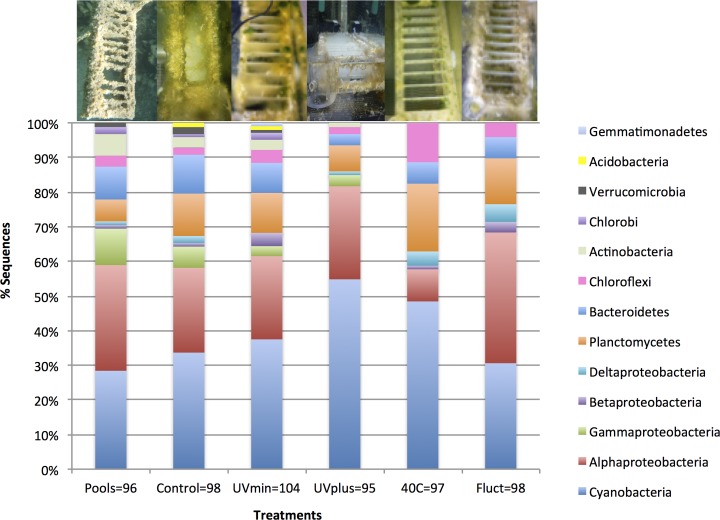
Relative abundance of bacterial taxonomic groups from the clone libraries data of the microbial mats in the treatments and the pools at the end of the experiment.The number of clones obtained from each environment is indicated below in its respective bar. The photo above each bar represents the “microbial mat catchers” in each environment.